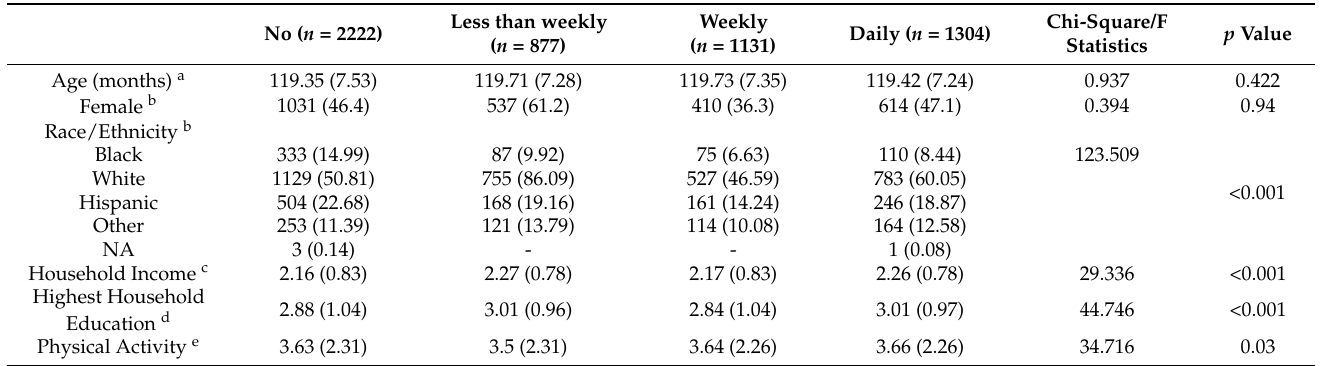
Table 1. Demographics of children with different PCEs.